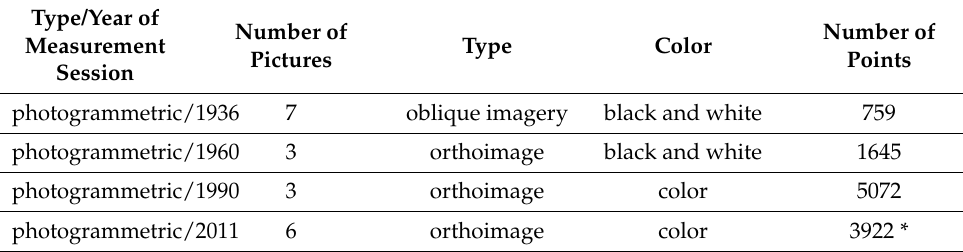
Table 1. Quantitative representation of the data used in long-term